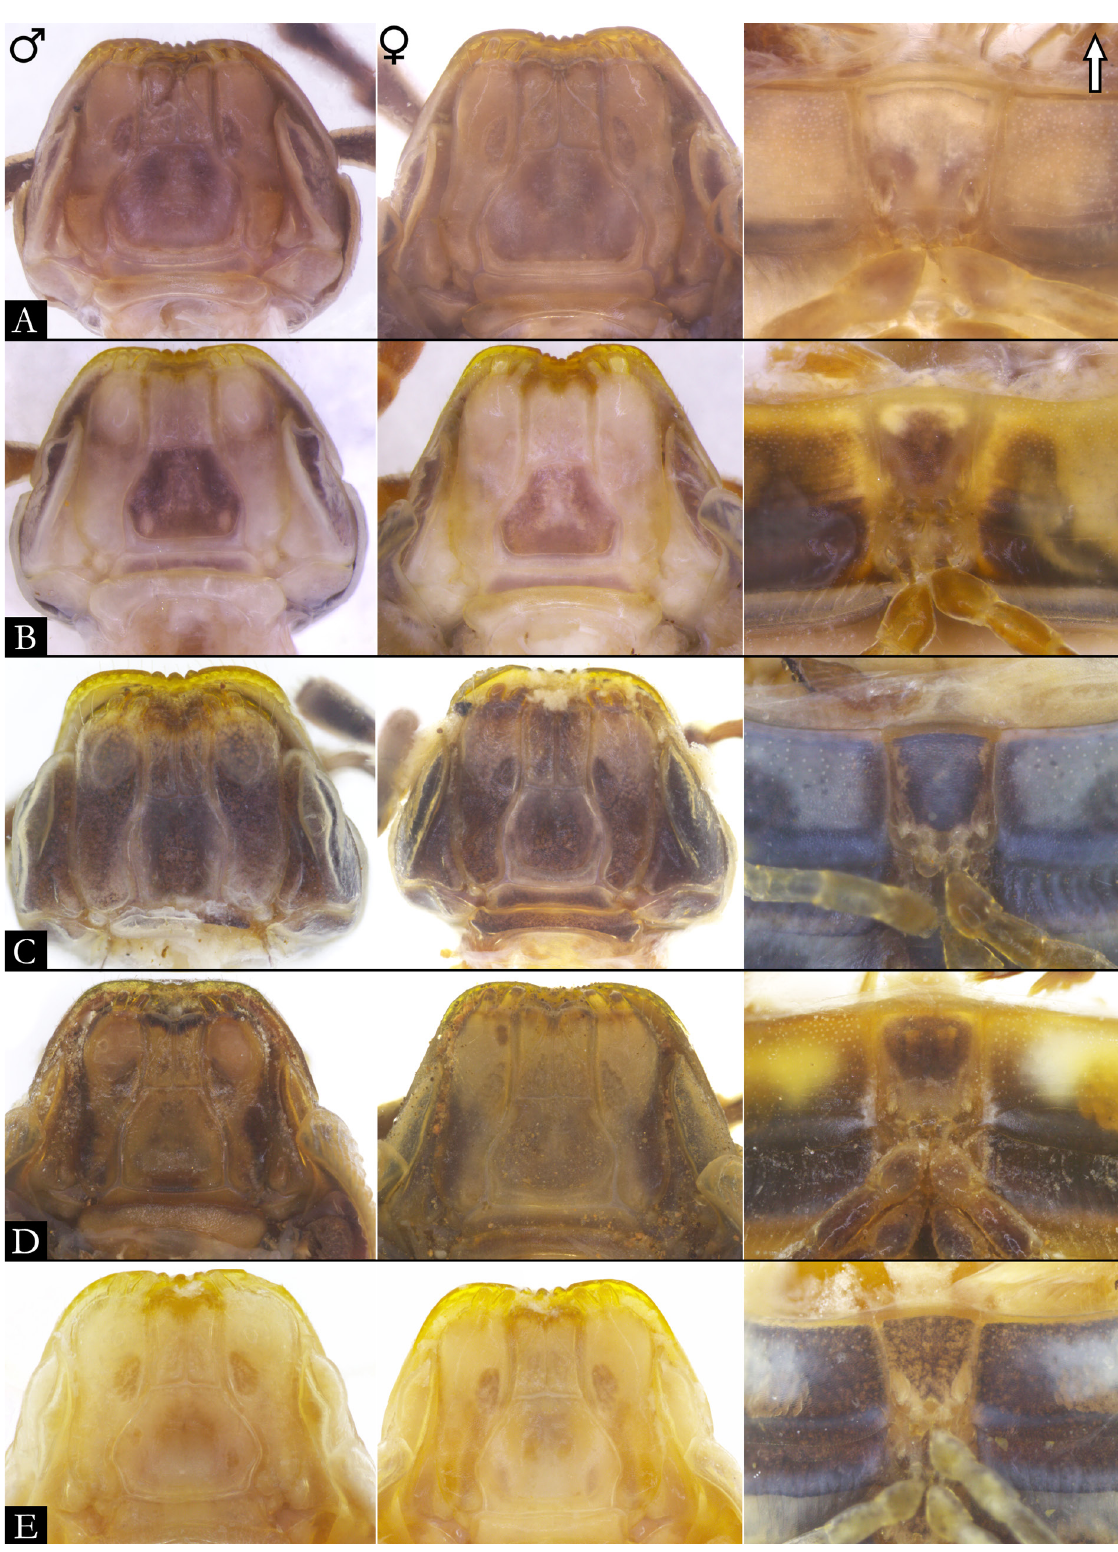
Fig. 175. Stereoscopic images of gnathochilarium and anterior sternum of species of Pseudonannolene Silvestri, 1895. A . P. granulata sp. nov. B . P. alata sp. nov. C . P. curvata sp. nov. D . P. aurea sp. nov. E . P. alegrensis . Images not to